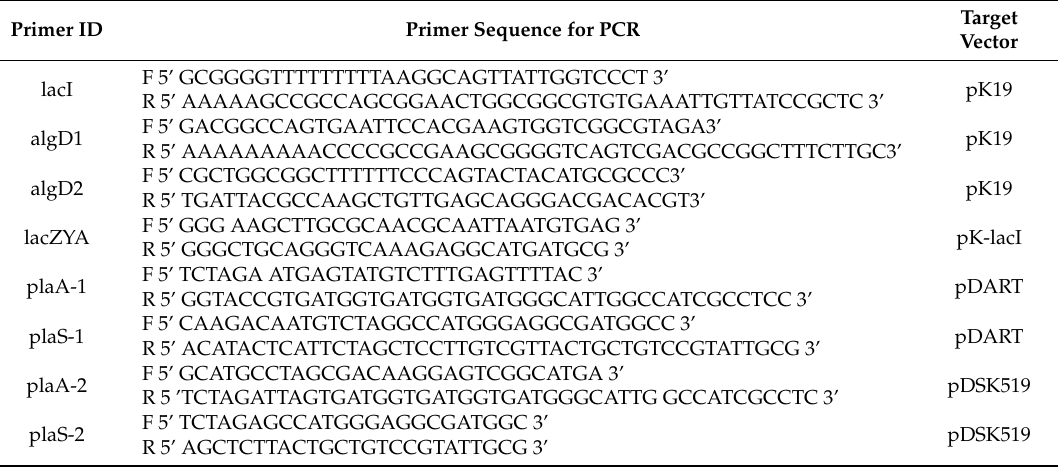
Table 1. List of primers used in this